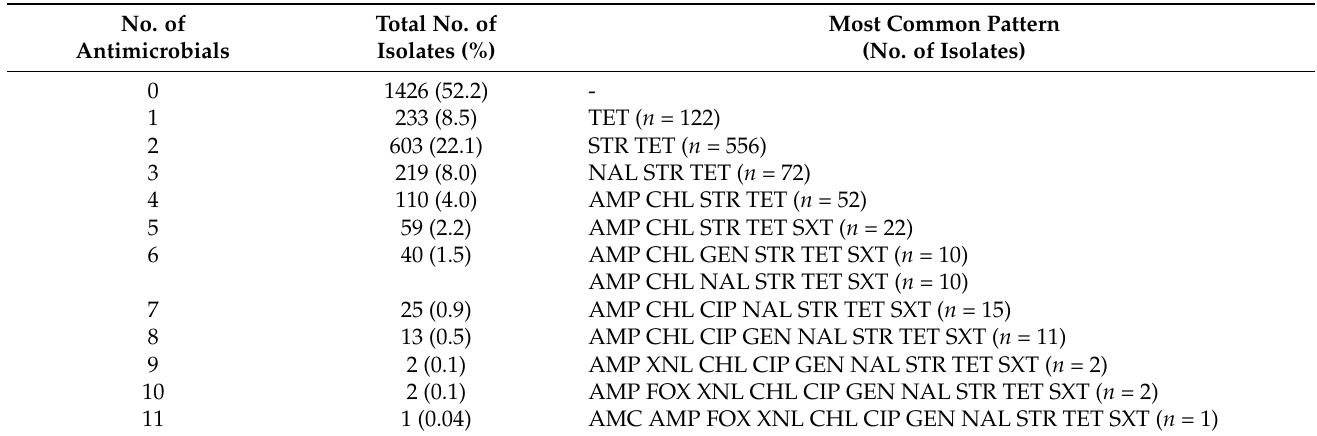
Table 3. Frequent resistance patterns in E. coli isolated from healthy cattle between 2010 and 2020 in Korea ( n =